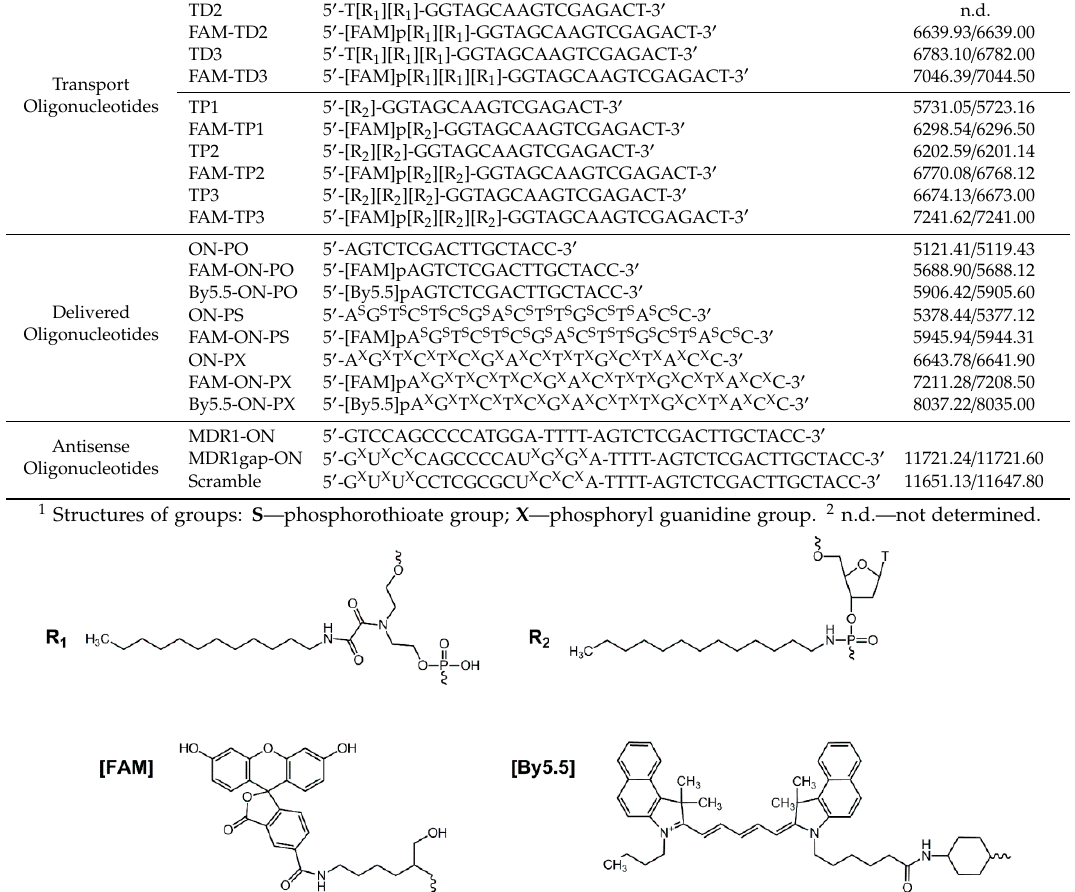
Table 1. Sequences, designations, and modifications of transport and antisense oligonucleotides used in the